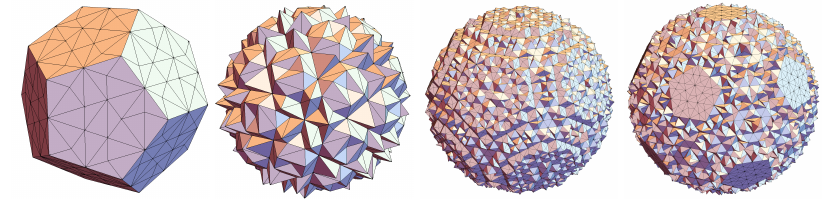
Figure 5. Various tilings T ( D 6 ) generated as projections D 6 → E 3 with randomly chosen shift vectors.